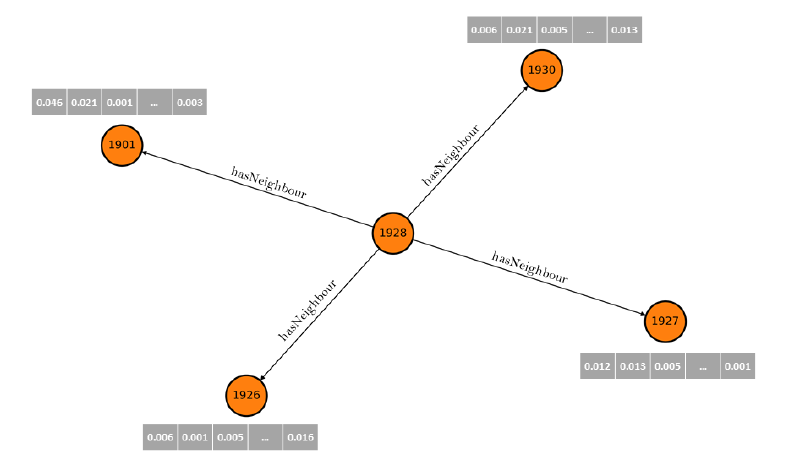
Figure 5. Representation of spatial objects in the form of a graph.